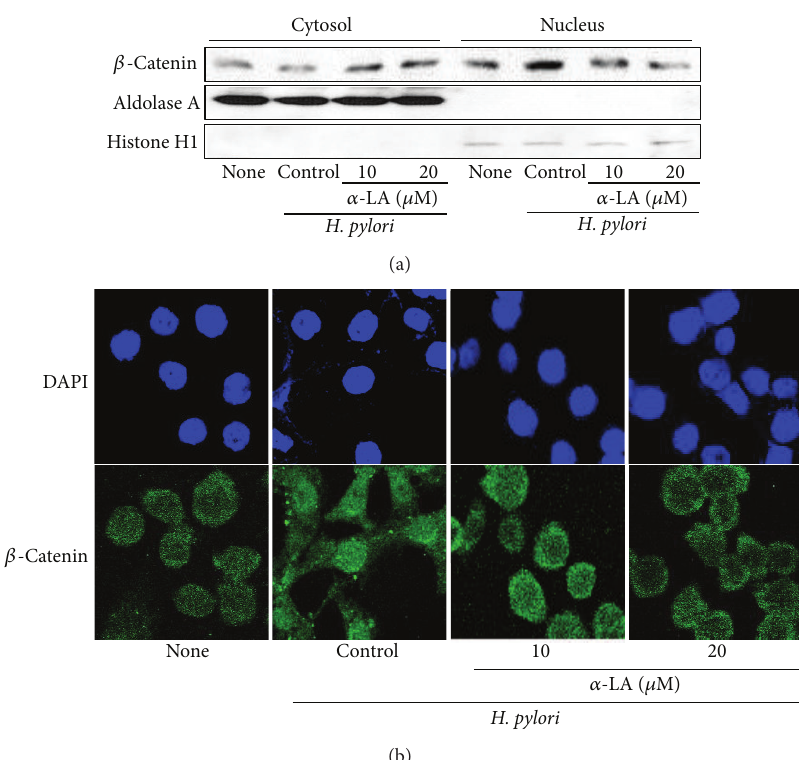
Figure 6: Effect of 𝛼 -LA on activation of 𝛽 -catenin in H. pylori -infected AGS cells. AGS cells were pretreated with 𝛼 -LA for 2 h and cultured in the presence or absence of H. pylori for 24 h. (a) Protein levels of 𝛽 -catenin in cytosolic and nuclear extracts were determined by Western blot analysis. Aldolase A and histone H1 were used as indices for cytosolic and nuclear extracts, respectively. (b) Immunofluorescence staining was performed to determine the levels of 𝛽 -catenin in nucleus and cytosol. 𝛽 -catenin was visualized using fluorescein isothiocyanate-conjugated anti-mouse IgG antibody (lower panel) with DAPI counter staining (upper panel) of the same